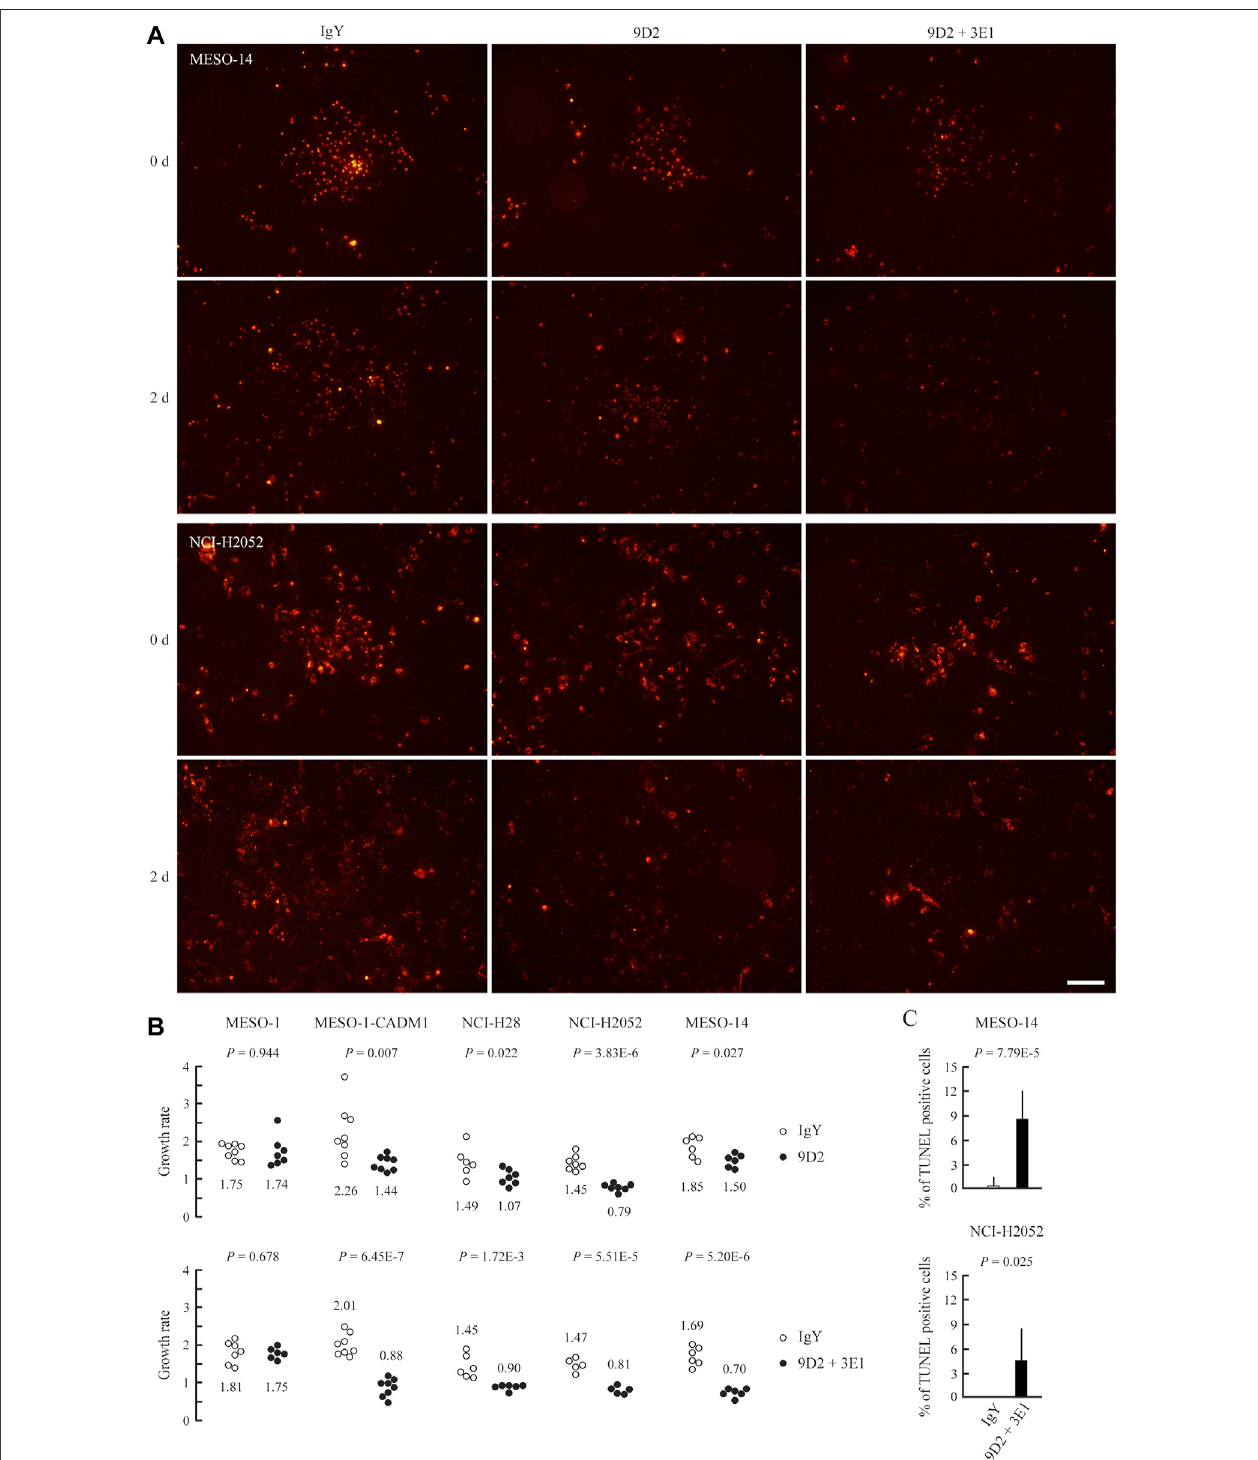
FIGURE 3 | Growth suppression of MPM cells on MeT-5A cells by 9D2 and 3E1 (A) MESO-14 and NCI-H2052 cell sheets were labeled with DiI (red) and were cocultured on a MeT-5A cell monolayer in the presence of control IgY (1.0 μ g/ml; left), 9D2 (1.0 μ g/ml; middle), or 9D2 and 3E1 (1.0 μ g/ml each; right). Cell sheets were observed through a fl uorescence microscope at the time of antibody addition (0 d) and after 2 days (2 d) (B) MESO-1, MESO-1-CADM1, NCI-H28, NCI-H2052, and MESO-14 cell lines were cocultured on a MeT-5A cell monolayer in the presence of either control IgY (1.0 μ g/ml) or 9D2 (1.0 μ g/ml) (upper graph), and in the presence of either control IgY (2.0 μ g/ml) or 9D2 and 3E1 (1.0 μ g/ml each) (lower graph). For individual cell sheets, the ratio of the cell number at the time of antibody